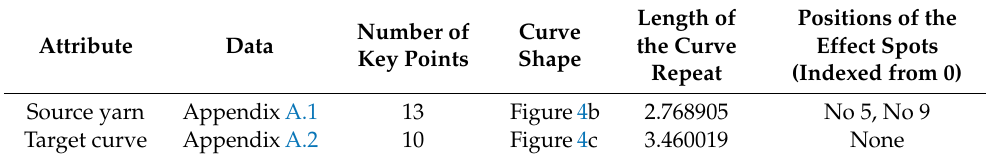
Table 1. Specifications of the source yarn and target curve.